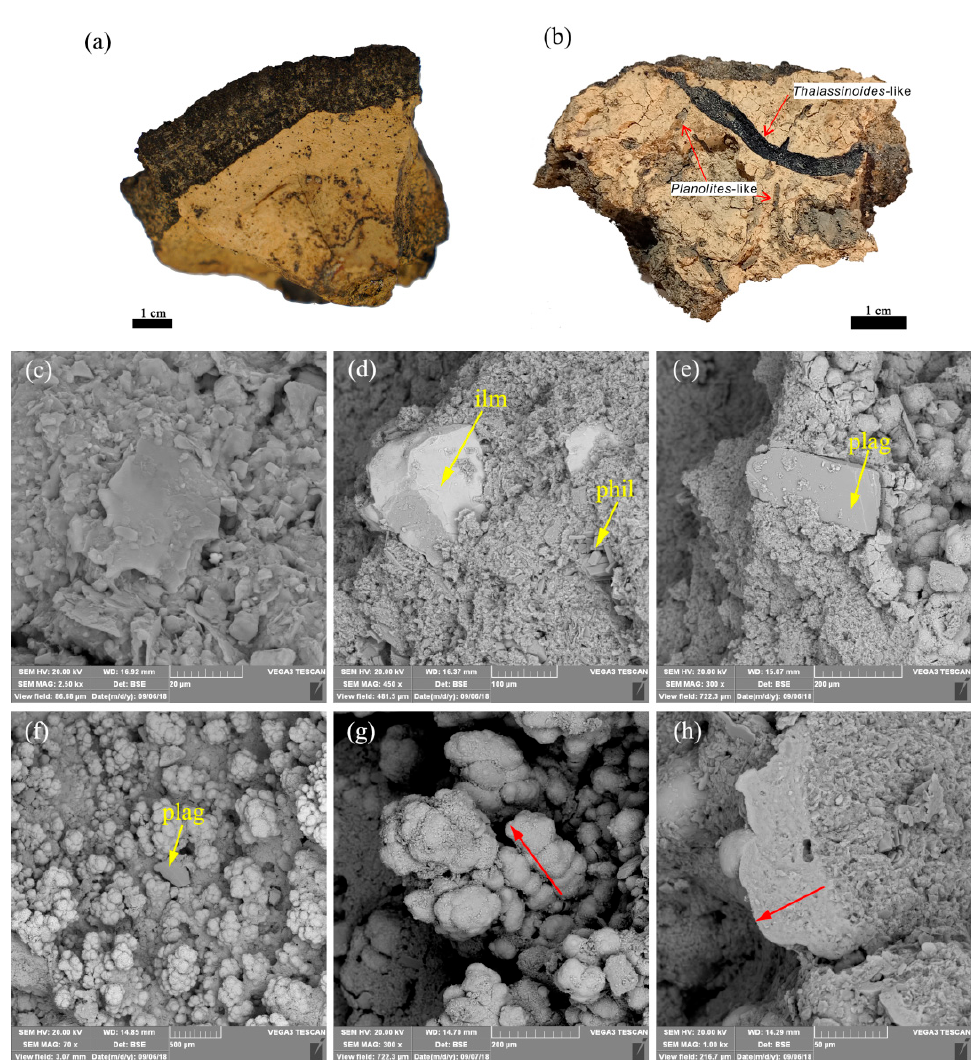
Figure 2. ( a , b ) Hand specimens of consolidated sediment samples; ( c , d ) SEM images of sediments; ( e – h ) SEM images of the interior of the burrows. ( a ) Indurated clay sediments underlie an outer Fe-Mn crust. Fine particles of Fe-Mn oxides are observed scattering inside the sediments. ( b ) Planolites -like and Thalassinoides -like burrow structures in a fragment of hard sediments. The Thalassinoides -like burrows are coated by black Fe-Mn oxides. Burrows are indicated by arrows. ( c ) The debris of detrital illite. ( d ) Large ilmenite (ilm) minerals trapped in the sediment matrix and prisms of phillipsite (phil) in the cavities. ( e ) Large fragment of plagioclase (plag) crystal (~300 μ m long) trapped in the boundary between the sediments and oxide coatings. ( f ) Overview of the interior of the burrow structure. A fragment of plagioclase crystal drops among the oxide pillars. ( g ) The upward growth of a columnar structure of hydrogenetic Fe-Mn oxide indicated by the arrow. The spheroidal surface morphology is caused by dozens of microspheres (each diameter is ~60 μ m). ( h ) The cross section of one microsphere accreting from the sediment matrix.